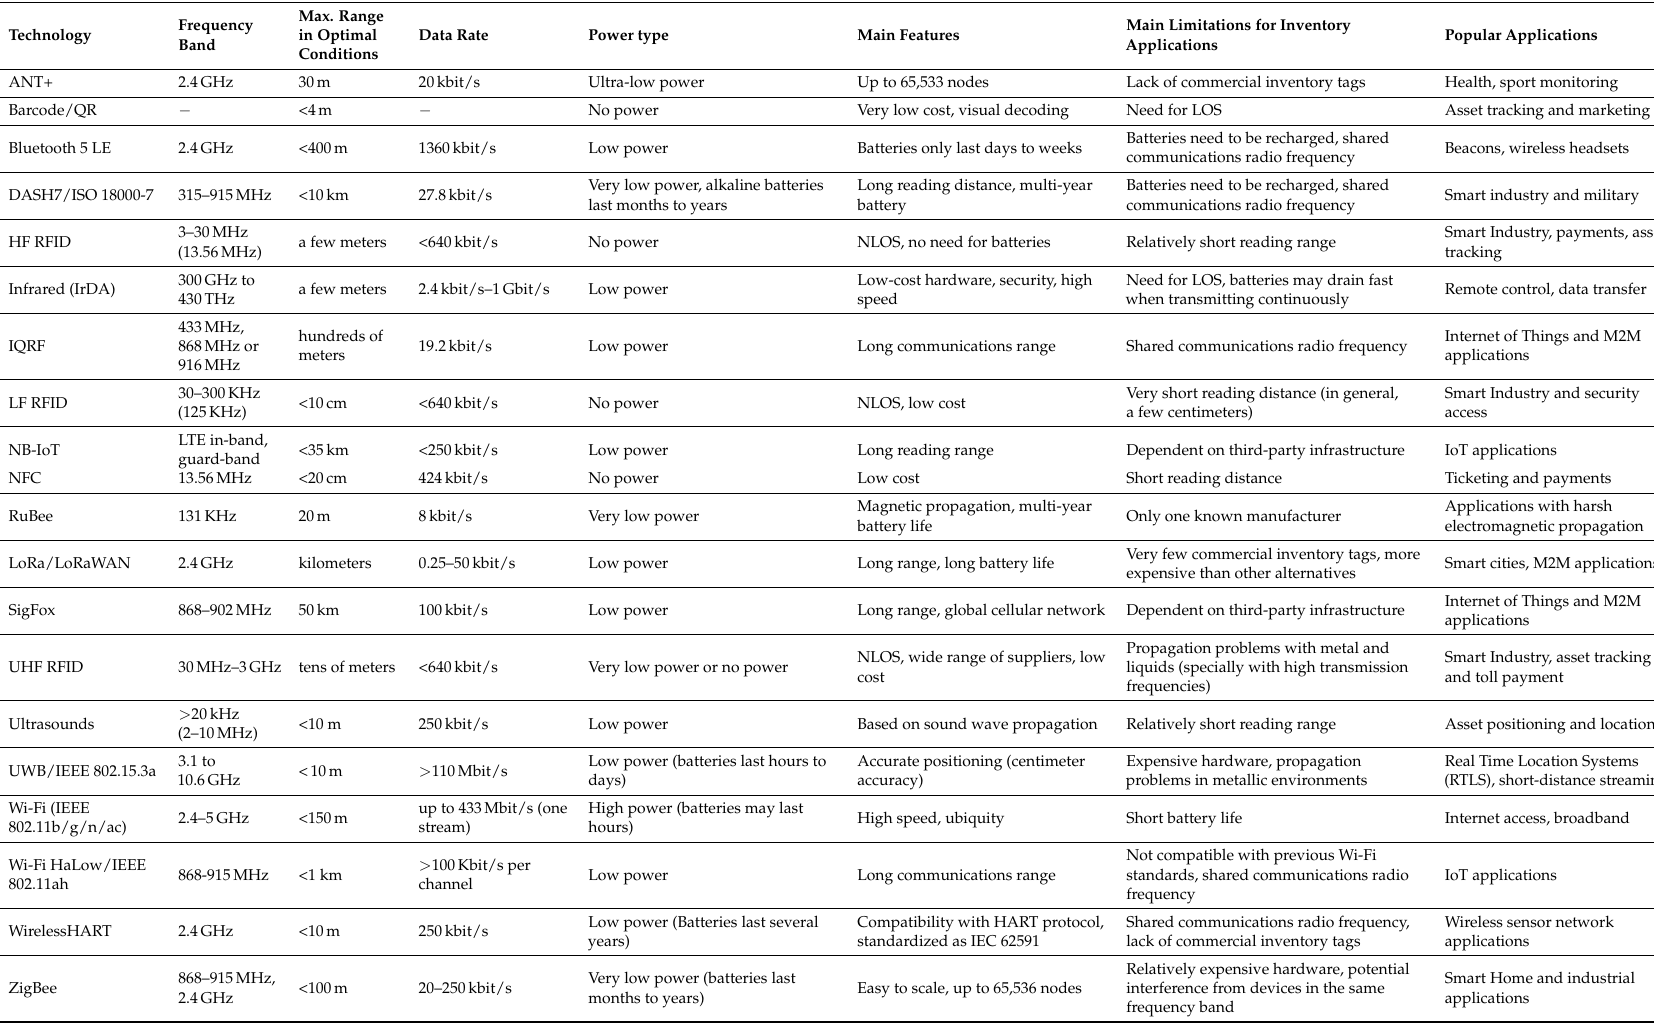
Table 1. Main characteristics of the most relevant communications and identification technologies for inventory and traceability